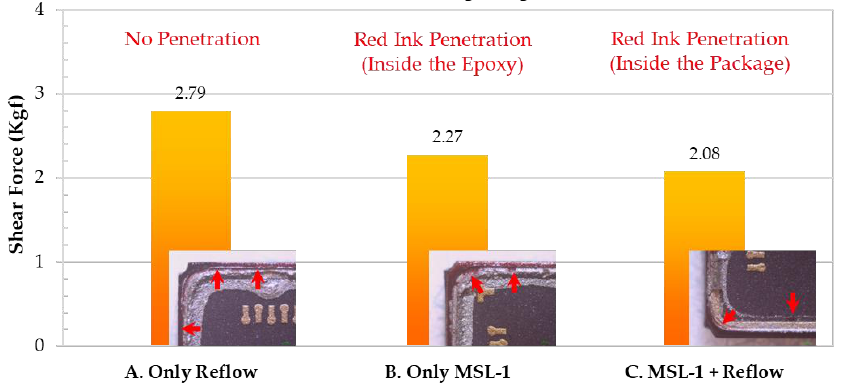
Figure 3. The process flow of investigating root cause. The shear test and the red dye penetration test results are presented in Figure 4. As can be seen from Result A (only reflow), the red ink is located at the outside of the MEMS package, indicating that no cracks have occurred at the interface or in the silver epoxy under the reflow process. When the MEMS package is exposed to high humidity, the moisture penetrates into the silver epoxy. As the residual moisture weakens the metal lid/silver epoxy bonding strength, the red ink penetrates inside the silver epoxy and the package, as indicated by both Result B (only MSL-1) and Result C (MSL-1 and reflow). The maximum shear force also decreases as a result of moisture penetration. Result C further reveals that the metal lid has separated from the silver epoxy, as the moisture inside the MEMS package cavity vaporizes and generates vapor pressure during the reflow process. Hence, the vapor pressure and the thermal pressure have a potential to cause the lid-off.